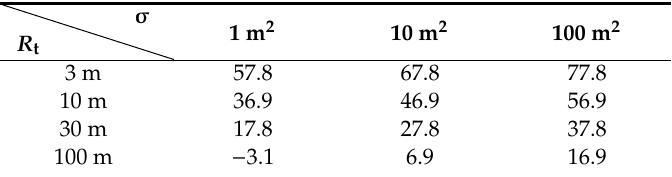
Table 5. Calculated values of the signal-to-noise ratio ( SNR Rt ) (dB) at the AR sensor receiver input for various RCS values and ranges considering real